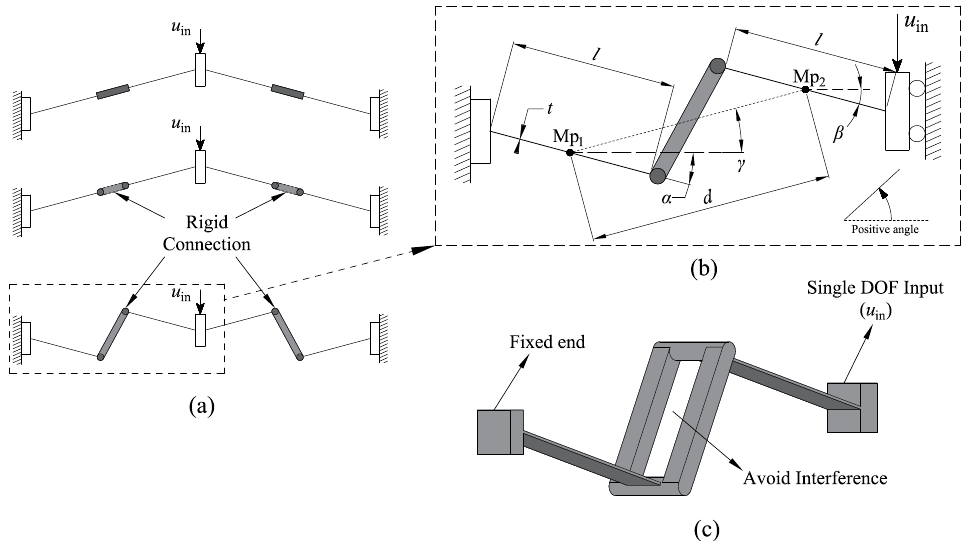
Figure 2. The generalized compliant bistable mechanism: ( a ) the derivation process from traditional compliant bistable mechanism to generalized mechanism; ( b ) The defined parameters; ( c ) The multi- layer analysis